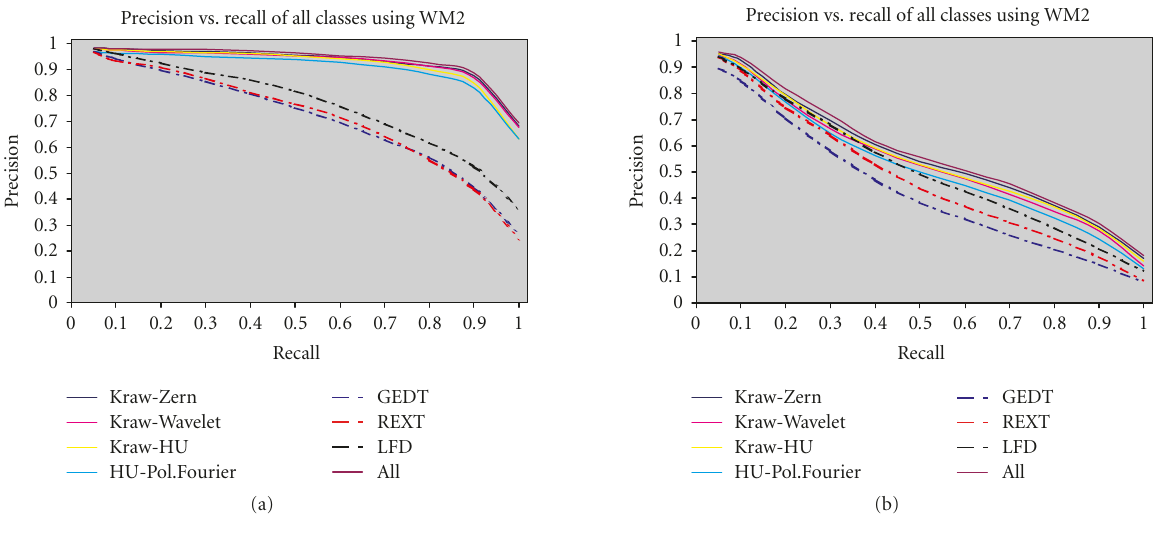
Figure 10: Precision-recall curves diagram some of the best descriptor vector combinations, using the weight method 2 for the new database (a) and for the Princeton database